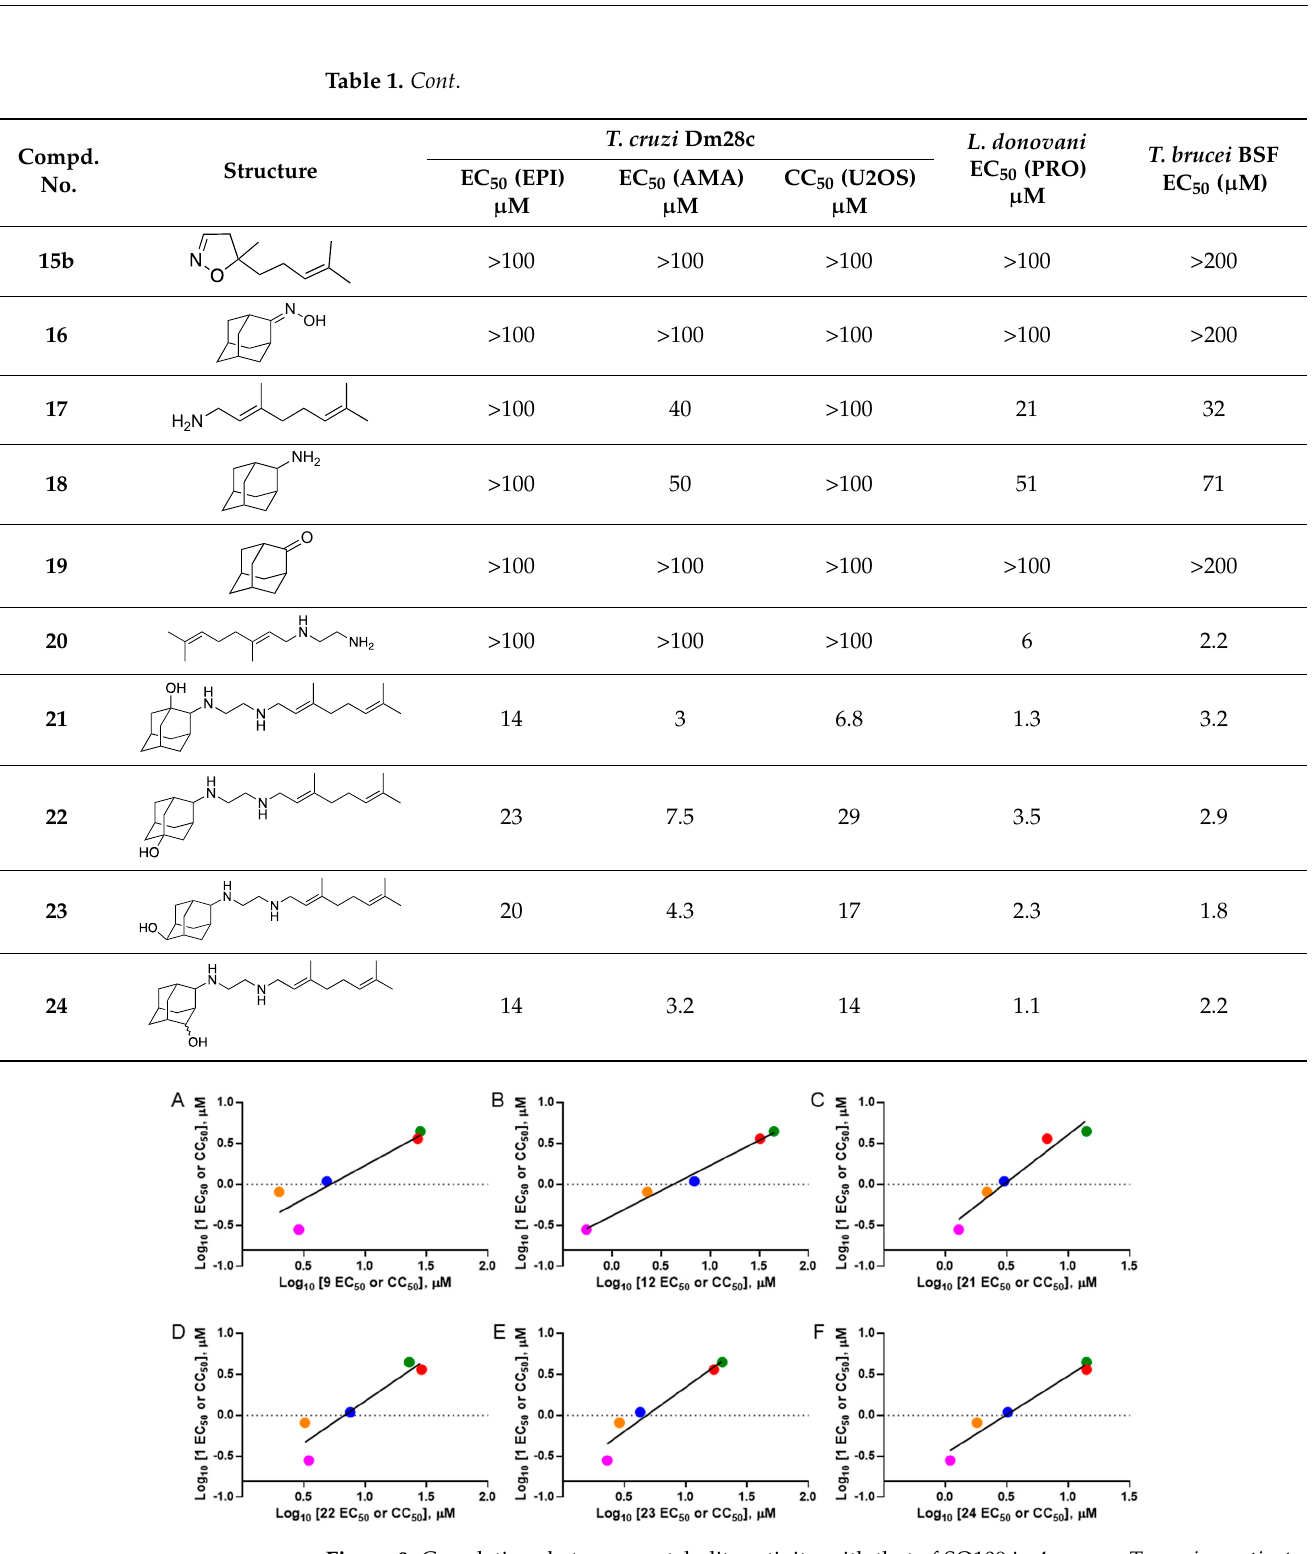
Figure 9. Correlations between metabolite activity with that of SQ109 in 4 assays: T. cruzi amastigotes (and the host U2OS cells), T. cruzi epimastigotes, L. donovani promastigotes and T. brucei BSFs. ( A ) Compound 9, r = 0.90 and p = 0.0373. ( B ) Compound 12, r = 0.99 and p = 0.0012. ( C ) Compound 21, r = 0.97 and p = 0.0062. ( D ) Compound 22, r = 0.93 and p = 0.0219. ( E ) Compound 23, r = 0.96 and p = 0.0095. ( F ) Compound 24, r = 0.98 and p = 0.0034. The color codes are T. cruzi epimastigotes = green ( ● ), T. cruzi amastigotes = blue ( ● ), U2OS = red ( ● ), T. brucei BSF = orange ( ● ), L. donovani pro- mastigotes = magenta ( ● ).